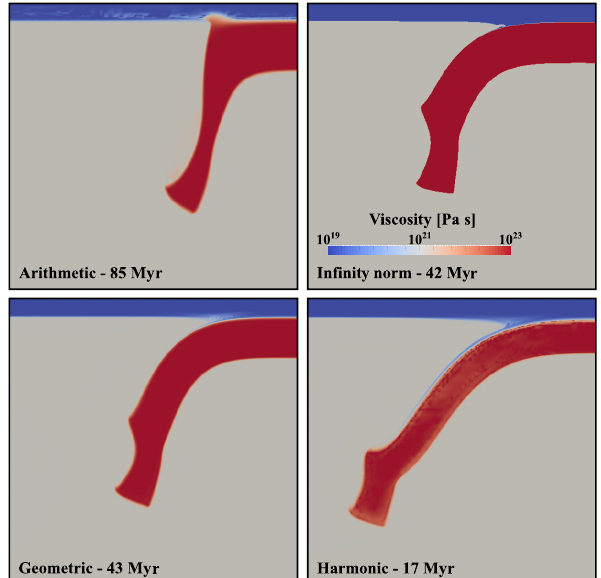
Figure A3. Viscosity field for each averaging method at 2048 × 512 element local resolution at similar moments in the subduction evolution.